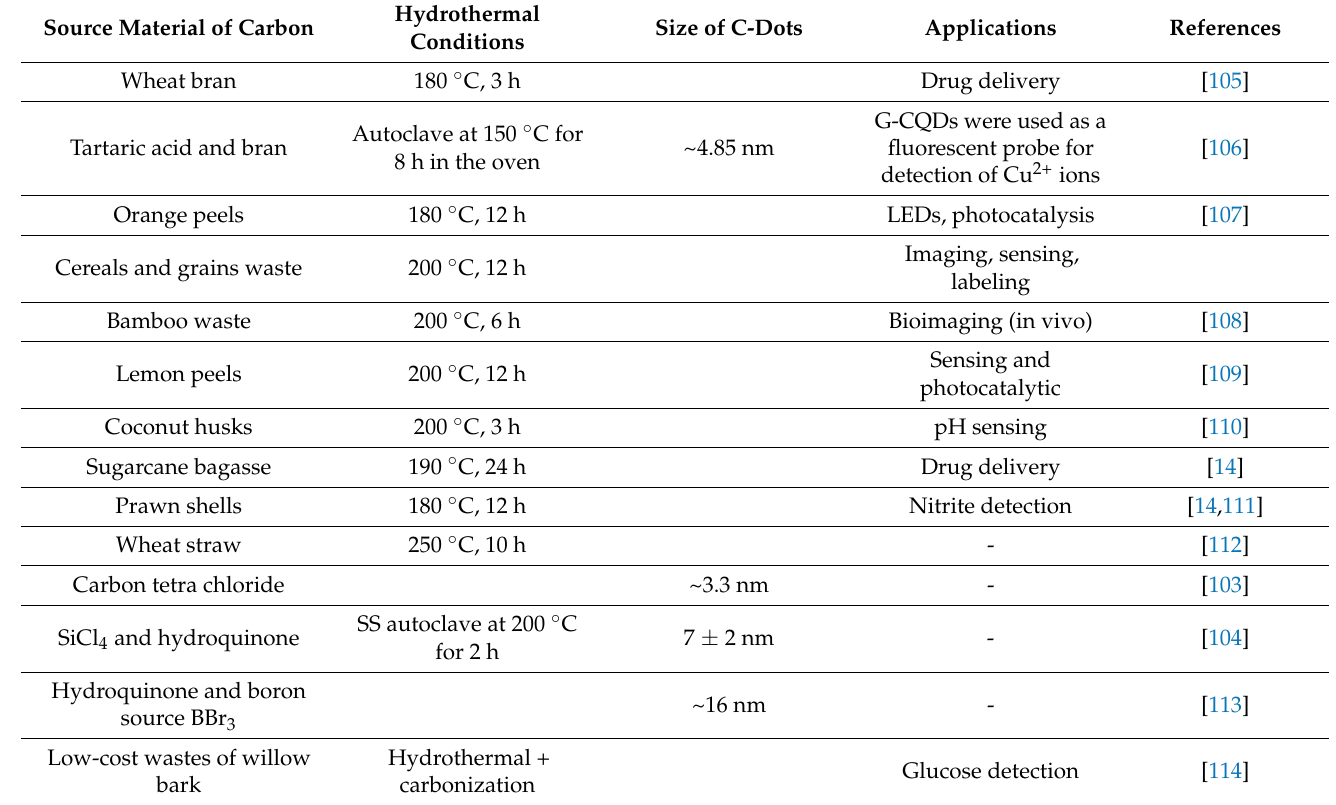
Table 8. Synthesis of C-dots by the solvothermal